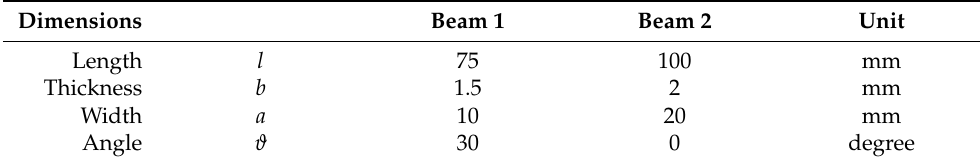
Figure 3. Mechanical system used in the simulations. Table 1. Geometrical characteristics of the model.